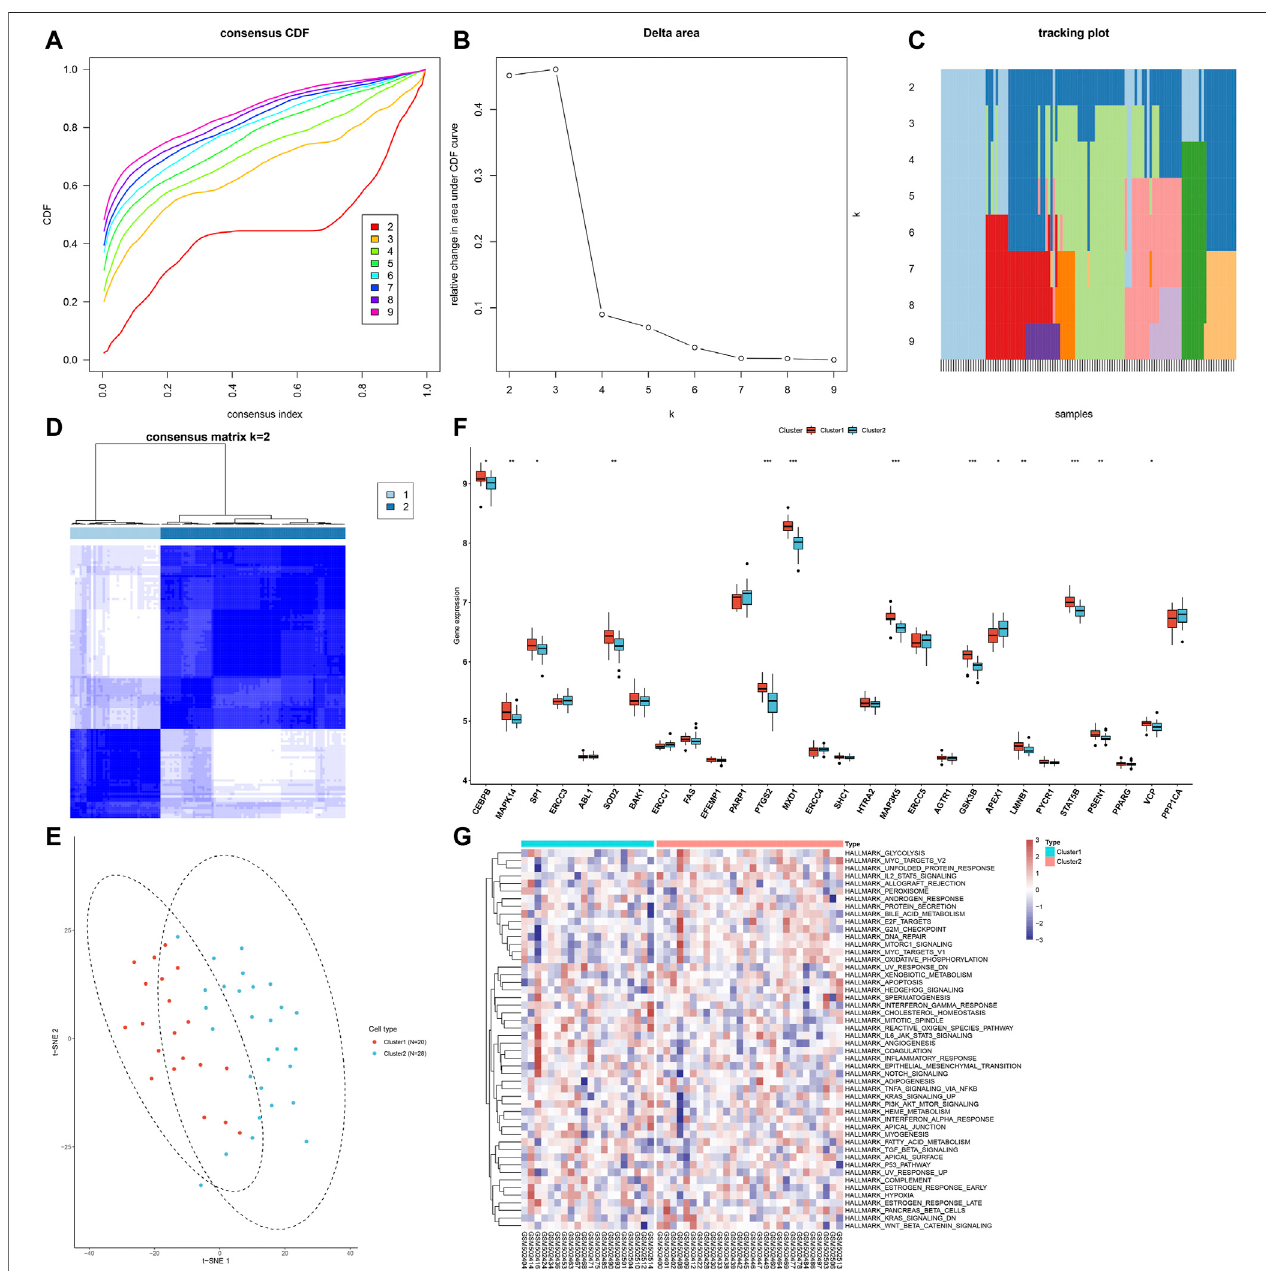
FIGURE4| Characterizationoftwoaging-relatedgeneclustersacrossASsamples. (A) Empiricalcumulativedistributionfunction(CDF)plotsdisplayingconsensus distribution for each k. (B) Relative change in the area under the CDF curve. (C) Item tracking plot showing the consensus cluster of items (in column) at each k (in row). (D) Consensus matrix plots depicting consensus values on a white to blue color scale ordered by consensus clustering when k (cid:1) 2. (E) t-SNE plots con fi rming the classi fi cation accuracy of two aging-related gene clusters across AS specimens. (F) Box plots showing the difference in mRNA expression of AS-speci fi c aging- related genes between clusters. * p < 0.05; ** p < 0.01; *** p < 0.001. (G) Heatmap visualizing the activities of hallmark pathways in two aging-related gene